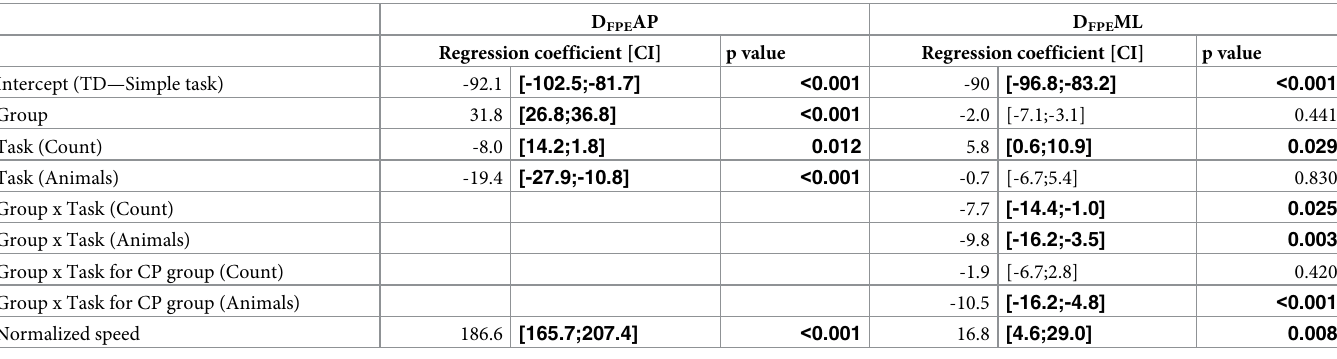
Table 2. Results of linear models for the D FPE (AP and ML).